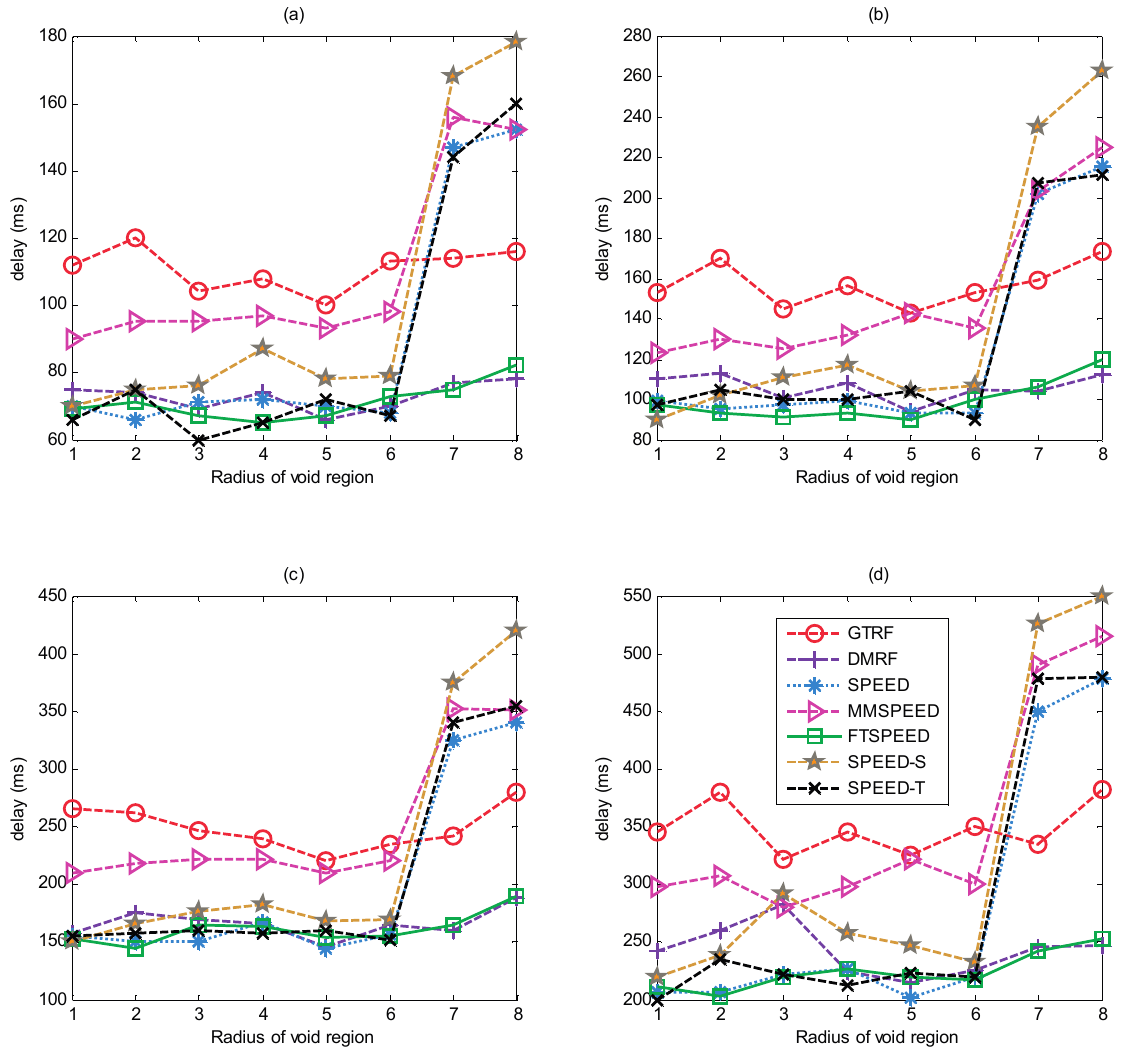
Figure 13. Comparison of transmission delay after transmitting ( a ) 1000; ( b ) 2000; ( c ) 5000 and ( d ) 10,000 packets under different routing